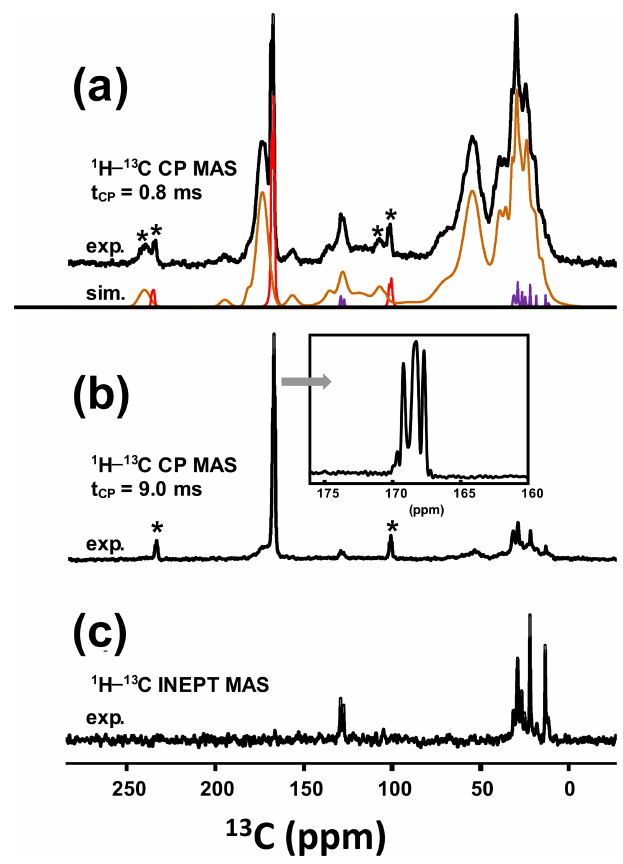
Figure 8. (a) 13 C CP MAS NMR spectrum of KS3 (recorded at 7.0T using a short contact time, i.e., 0.8ms; ν rot = 5kHz). The ex- perimental spectrum is decomposed into the following three compo- nents: COM (in red), fatty acids (in purple) and proteins (in brown). (b) 13 C CP MAS NMR spectrum of KS3 (recorded at 7.0T using a long contact time, i.e., 9.0ms). The inset highlights the COM con- tribution (four resonances, with two of them almost overlapping; Colas et al., 2013). (c) 1 H − 13 C refocused INEPT J-MAS NMR spectrum of KS3 (recorded at 7.0T). The unsaturations of the fatty acids are clearly evidenced at δ iso ( 13 C) ∼ 130ppm. The asterisk ( ∗ ) indicates the spinning